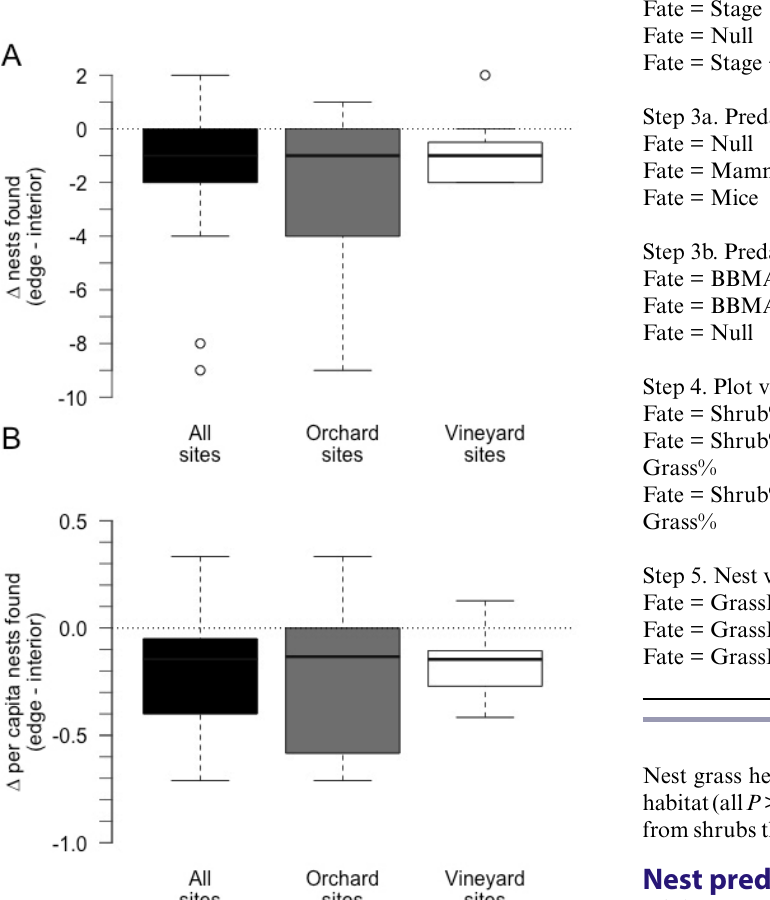
Fig. 2 . A. Difference in the number of songbird nests found in edge and interior sagebrush habitat. Difference in the number of nests was calculated as the number of nests in each edge plot minus the number of nests in the paired interior plot. B. Difference in the number of per capita songbird nests found in edge and interior sagebrush habitat. Difference in per capita nests was calculated as the mean nests per songbird in each edge plot minus the mean nests per songbird in the paired interior plot. Edge habitat was located adjacent to vineyard (n = 8) or orchard (n = 10). All sites includes orchard and vineyard sites pooled. Box ends represent the 25th and 75th percentiles, whiskers represent 1.5 interquartile range, and dots represent outliers in all boxplots.